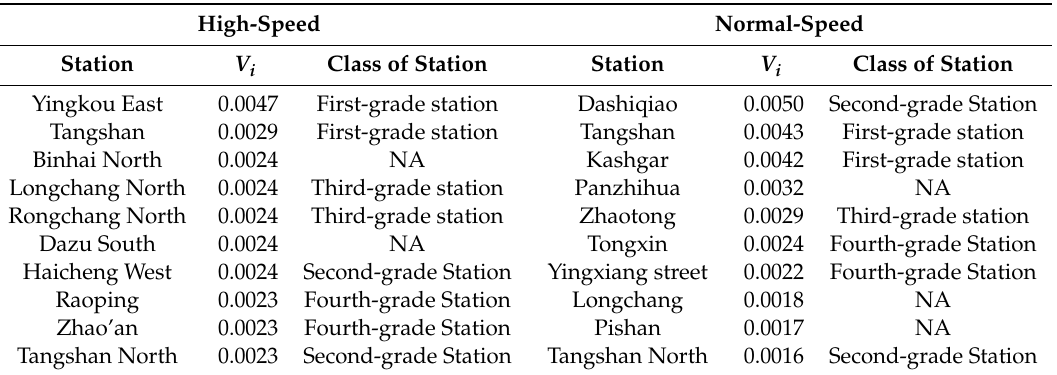
Table 5. Important stations in the geographic railway